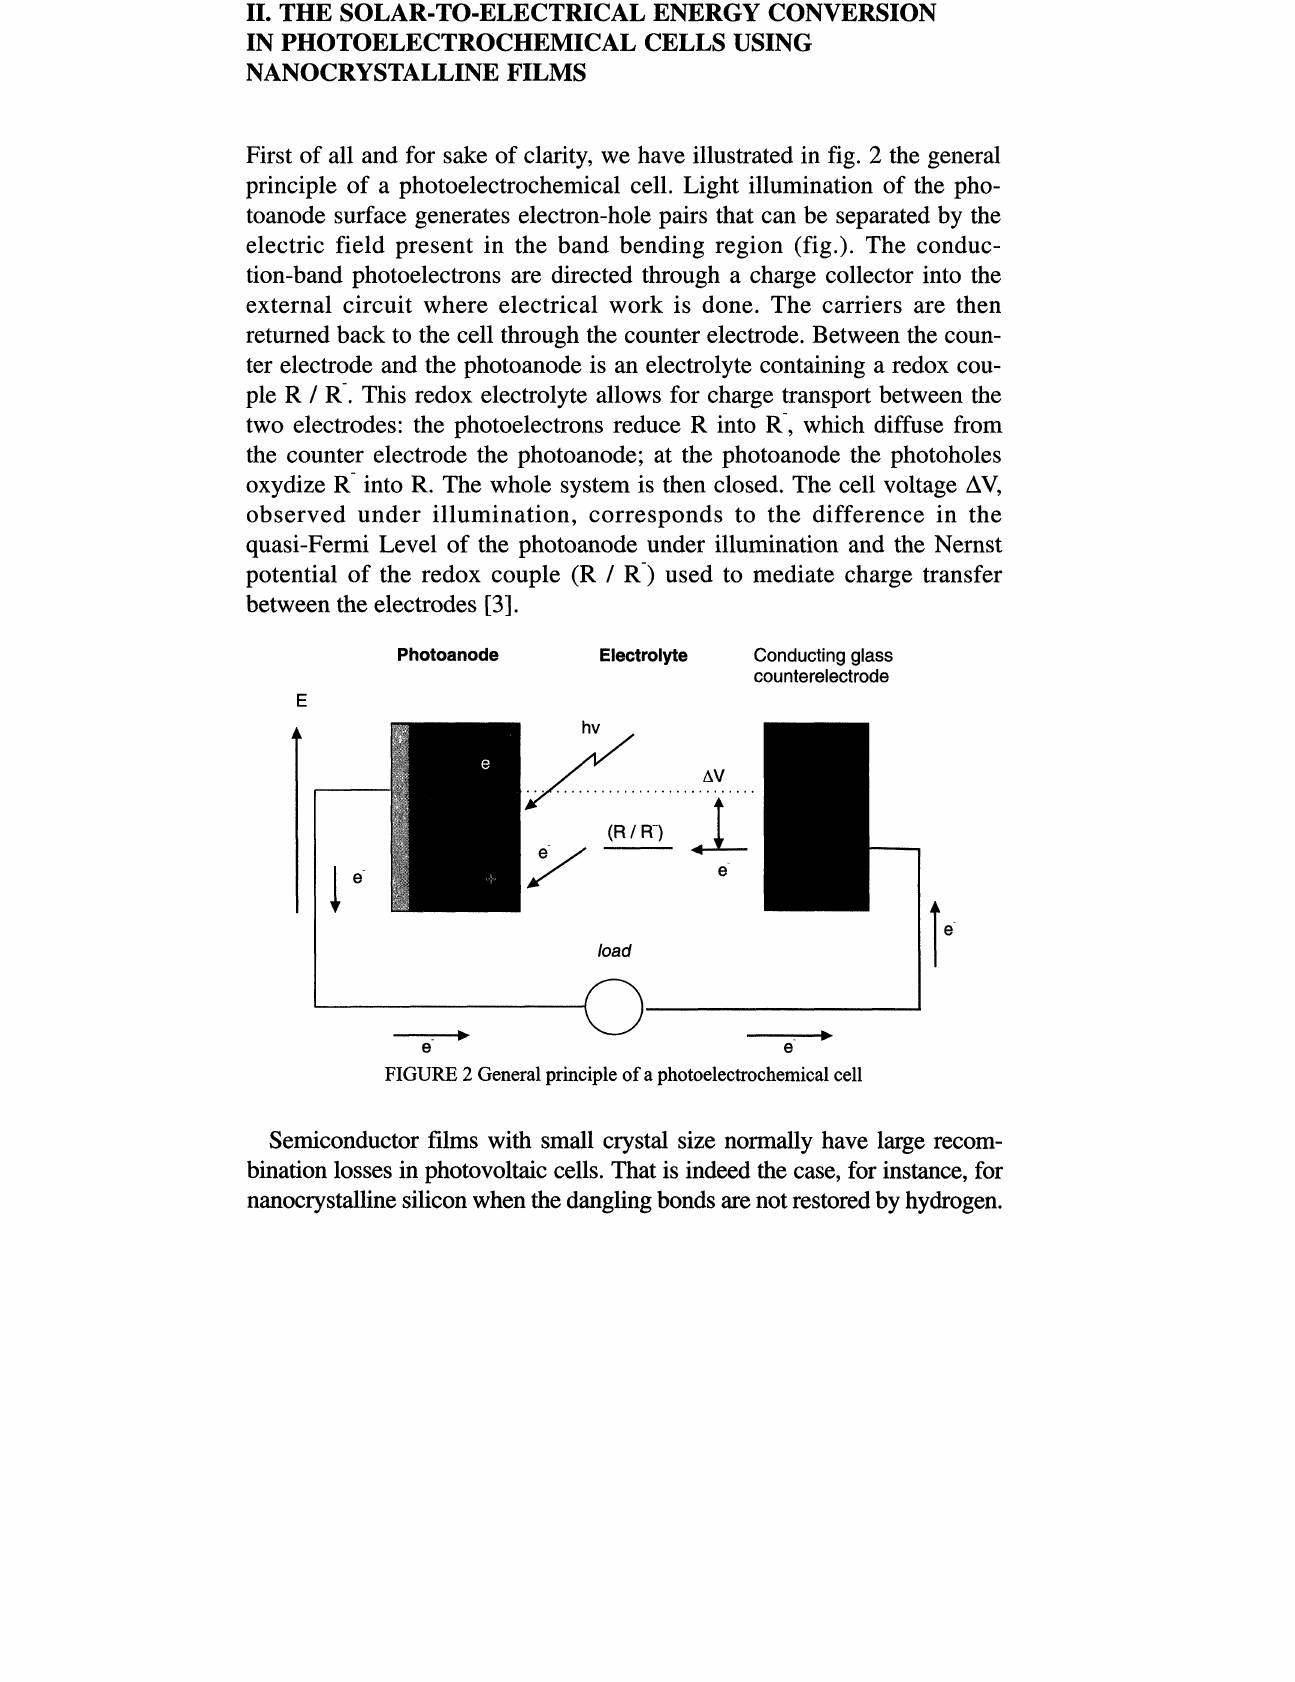
FIGURE 2 General principle of a photoelectrochemical